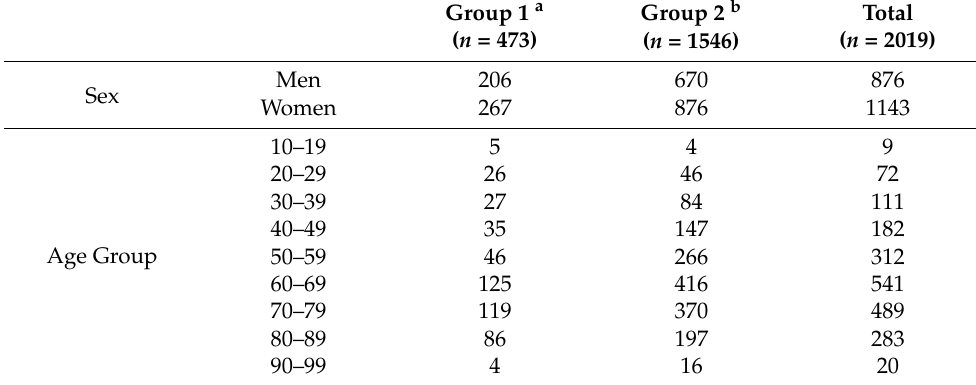
Table 1. Sex and age distribution between Asthma Control Test result